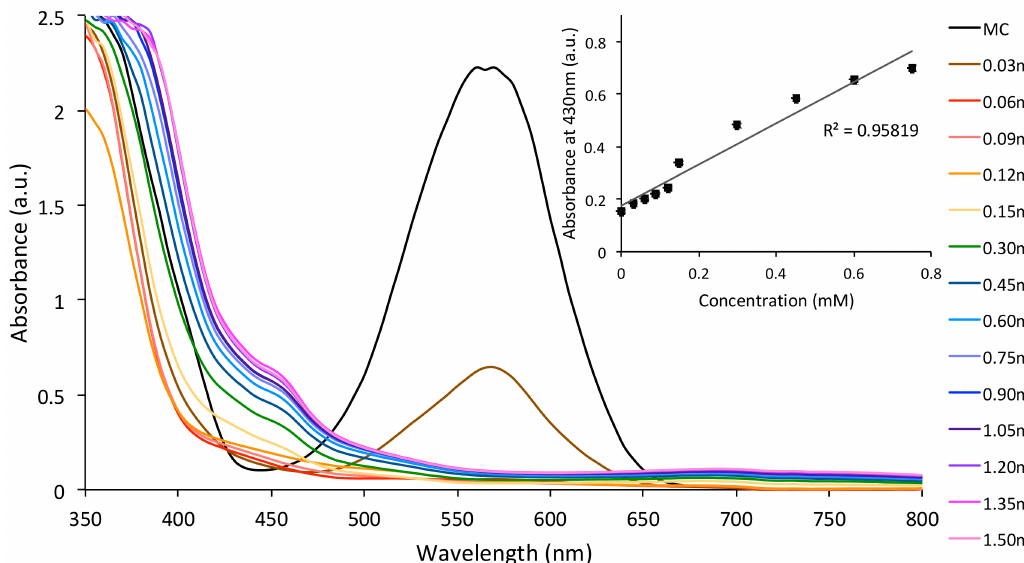
Figure 4. Absorbance changes of the SP solutions in ACN (1.5 × 10 − 3 M) in the presence of increasing concentrations of Cu 2+ (0–1.5 mM) after irradiation with UV light; Inset shows the linear dependence of the absorbance at λ max ≈ 430 nm (MC:Cu 2+ ) as a function of Cu 2+ concentration (0–0.8